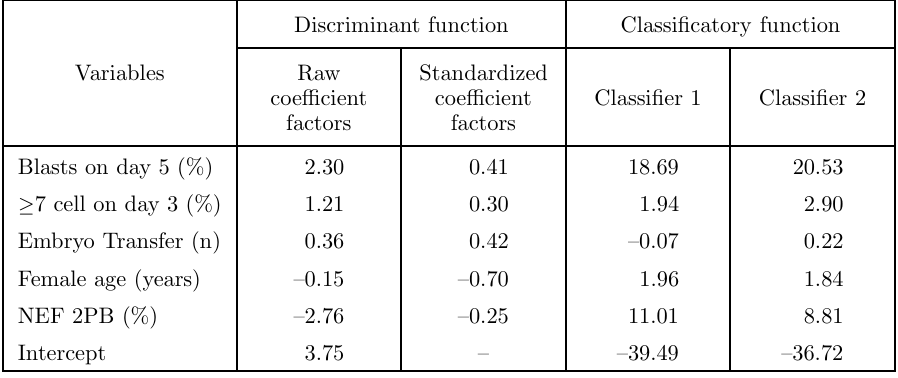
Table 2. Coefficient factors of the model (training set) Discriminant function Classificatory function Variables Raw Standardized coefficient coefficient Classifier 1 Classifier 2